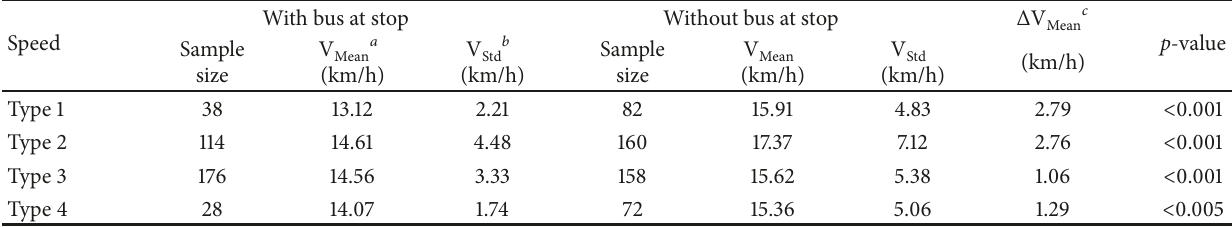
Table 2: Statistical tests for speed differences of all bicycles [21].